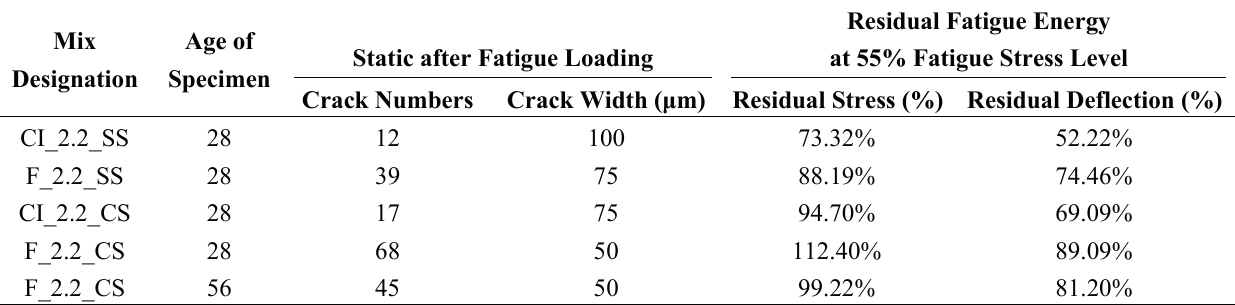
Table 9. Fatigue loading characteristics of fly ash ECC mixtures at one million